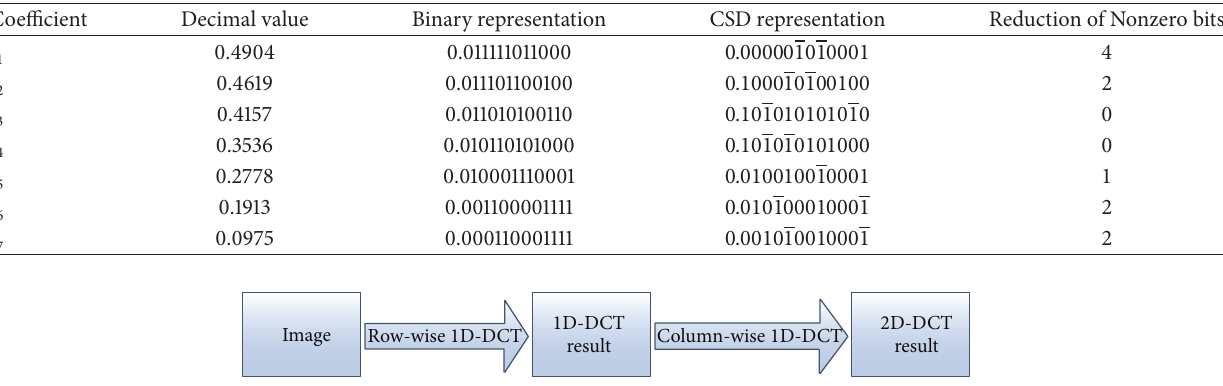
Figure 1: 2D-DCT using separability